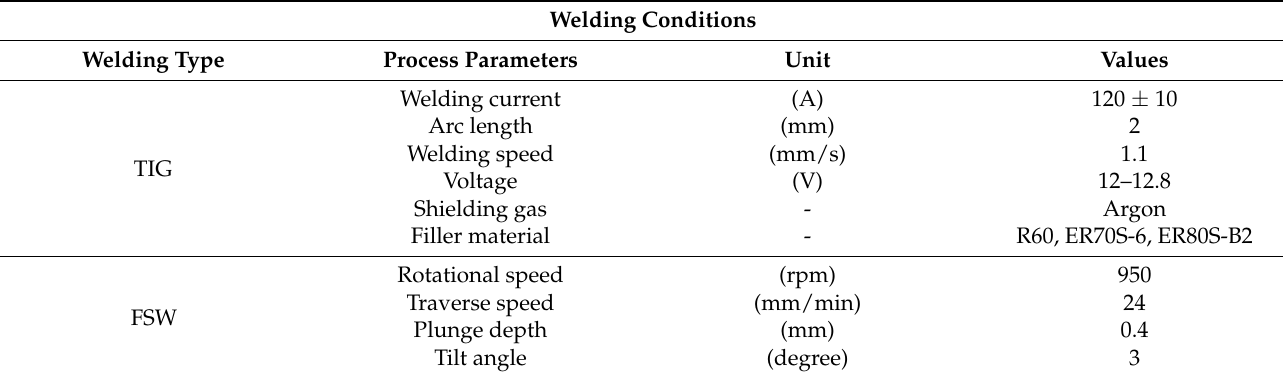
Table 2. Welding input